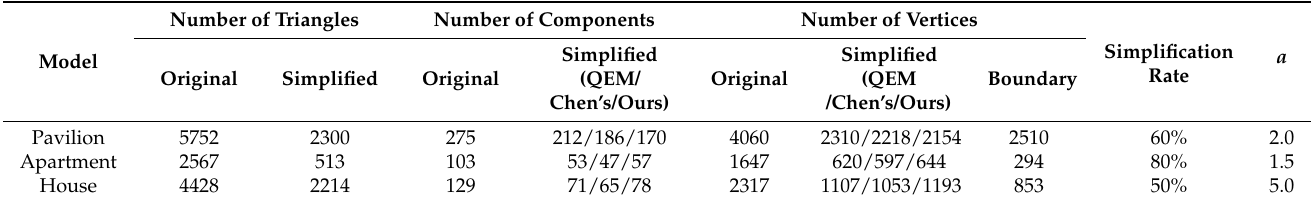
Table 1. Simplification statistics for the three building